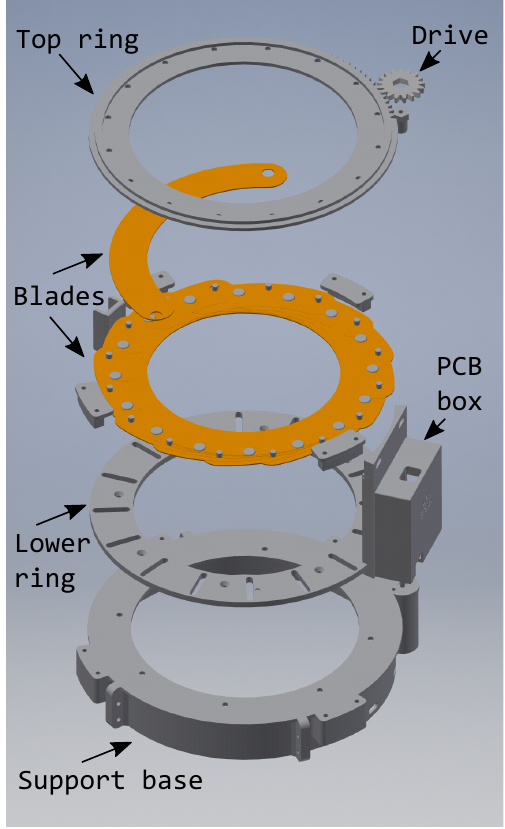
Figure 4. Exploded view and assembly drawing.